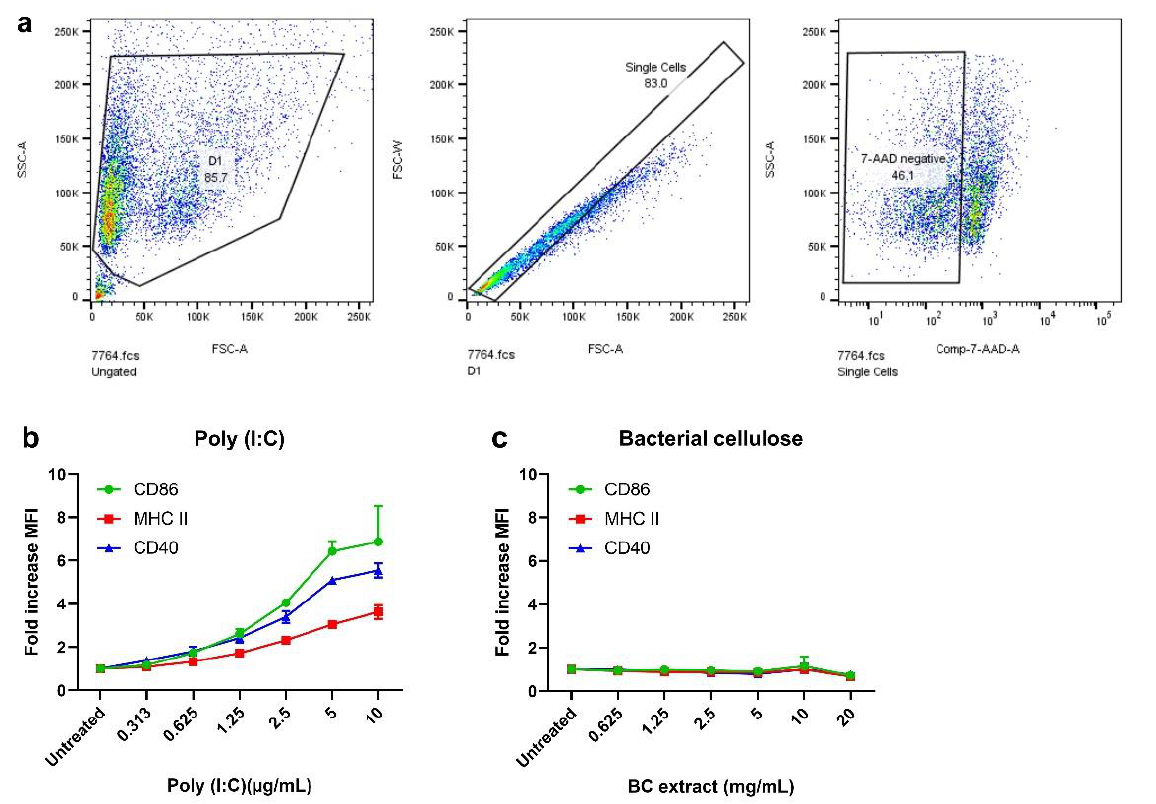
Figure 4. BC extracts do not induce DC maturation. BC extracts (max concentration 20 mg/mL) were co-cultured with D1DCs. After 48 h, D1DCs were harvested to assess the expression of CD40, CD86 and MHC-II activation markers with FACS. Debris, doublet cells and dead cells (7-AAD positive) were gated out ( a ). Next, the fold increases in MFI (the MFI of treated cells relative to untreated controls) were calculated for poly (I:C) ( b ) and BC extracts ( c ). Data are shown as mean ± SD for triplicate measurements.